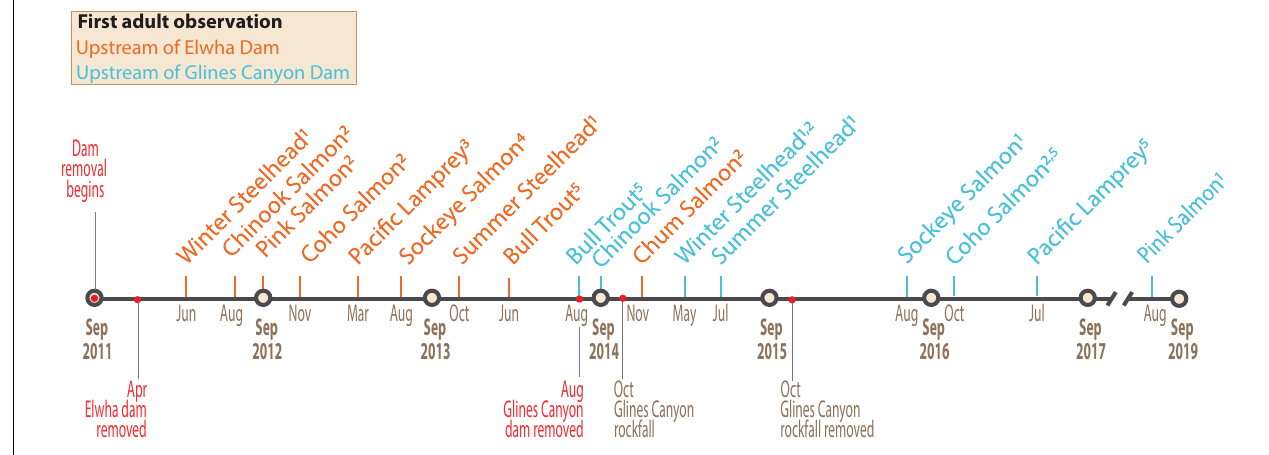
FIGURE 2 | Timeline showing the dates of dam removal and first observations of adult migratory fish upstream of Elwha Dam (orange lines) and Glines Canyon Dam (blue lines). Observations were compiled from ongoing field studies indicated by superscripts: (1) snorkeling surveys; (2) redd surveys; (3) smolt trapping; (4) tangle netting; and (5) radio-telemetry ( Supplementary Table 1 ). A recent environmental DNA study (Duda et al., 2021) detected some species earlier upstream of Elwha Dam (Chum Salmon in Aug 2014) and Glines Canyon Dam (Pink Salmon in August 2014, Pacific Lamprey and Sockeye Salmon in September 2014, and Chum Salmon in January of 2016), but this method cannot distinguish between adult and